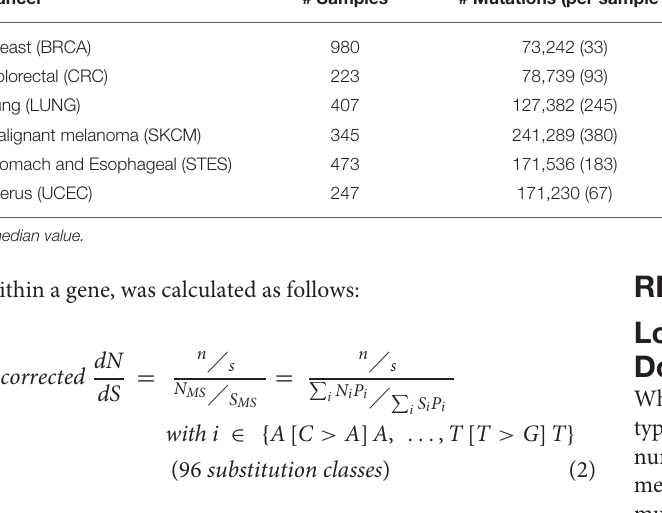
TABLE 1 | Summary statistics of the analyzed cancer types.